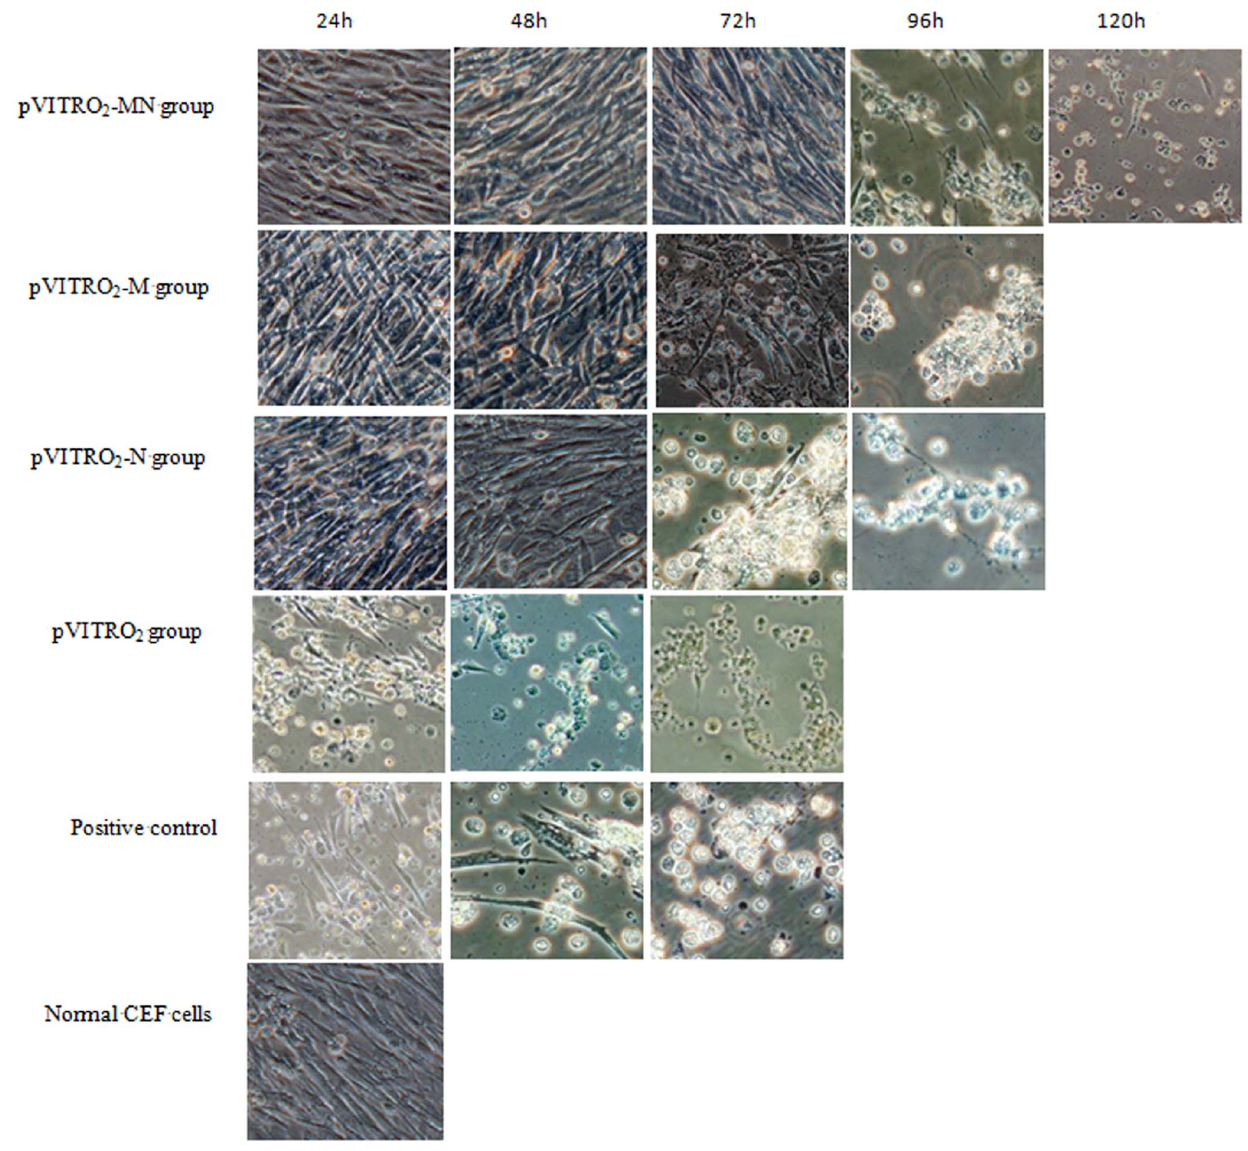
Figure 3. The cell morphology of CEF inoculated NDV for each transfection group at different time (200 6 ). CEF cells were transfected with pVITRO 2 -Mx-NA, pVITRO 2 -Mx, pVITRO 2 -NA and pVITRO 2 . After G418 selection for two weeks, the transfected CEF cells were trypsinized and seeded into 6-well plates. After overnight cultivation, 100 TCID 50 NDV was added to each well (in triplicates) and incubation was continued for 1 h at 37 u C. After 24 h, 48 h, 72 h, 96 h and 120 h infection, cell cultures were observed under microscope for cytopathic effect (CPE) and 50% CPE inhibition was recorded as described. Normal CEF cells infected with NDV was used as a positive control. pVITRO 2 -Mx-NA: pVITRO 2 -MN; pVITRO 2 -Mx: pVITRO 2 -M; pVITRO 2 -NA: pVITRO 2 -N.